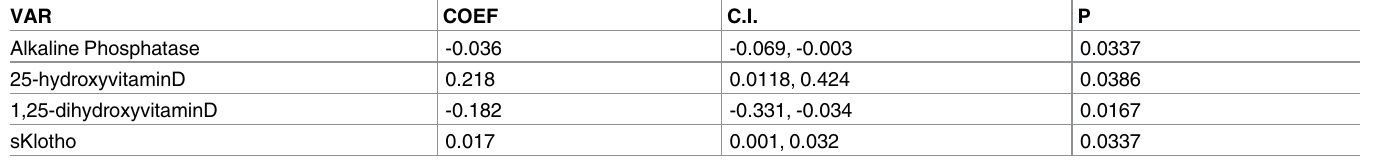
Table 3. Age adjusted multivariate analysis with Sclerostin as predicted variable.